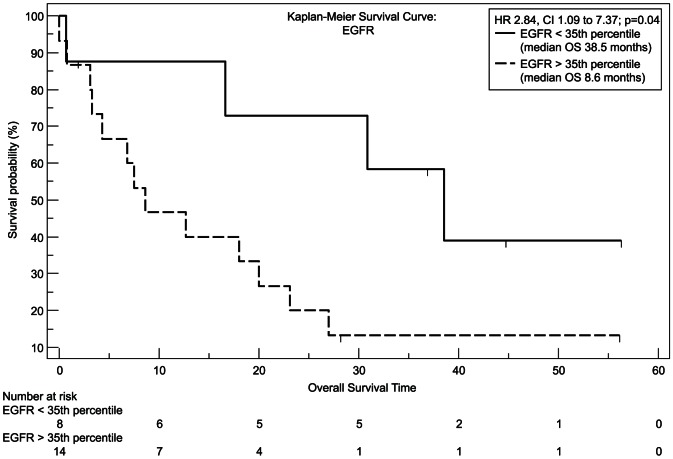
Kaplan-Meier plot, estimating overall survival.Differences in survival between the high (interrupted line) and the low (continuous black line) EGFR expression group were analyzed with the log-rank test.